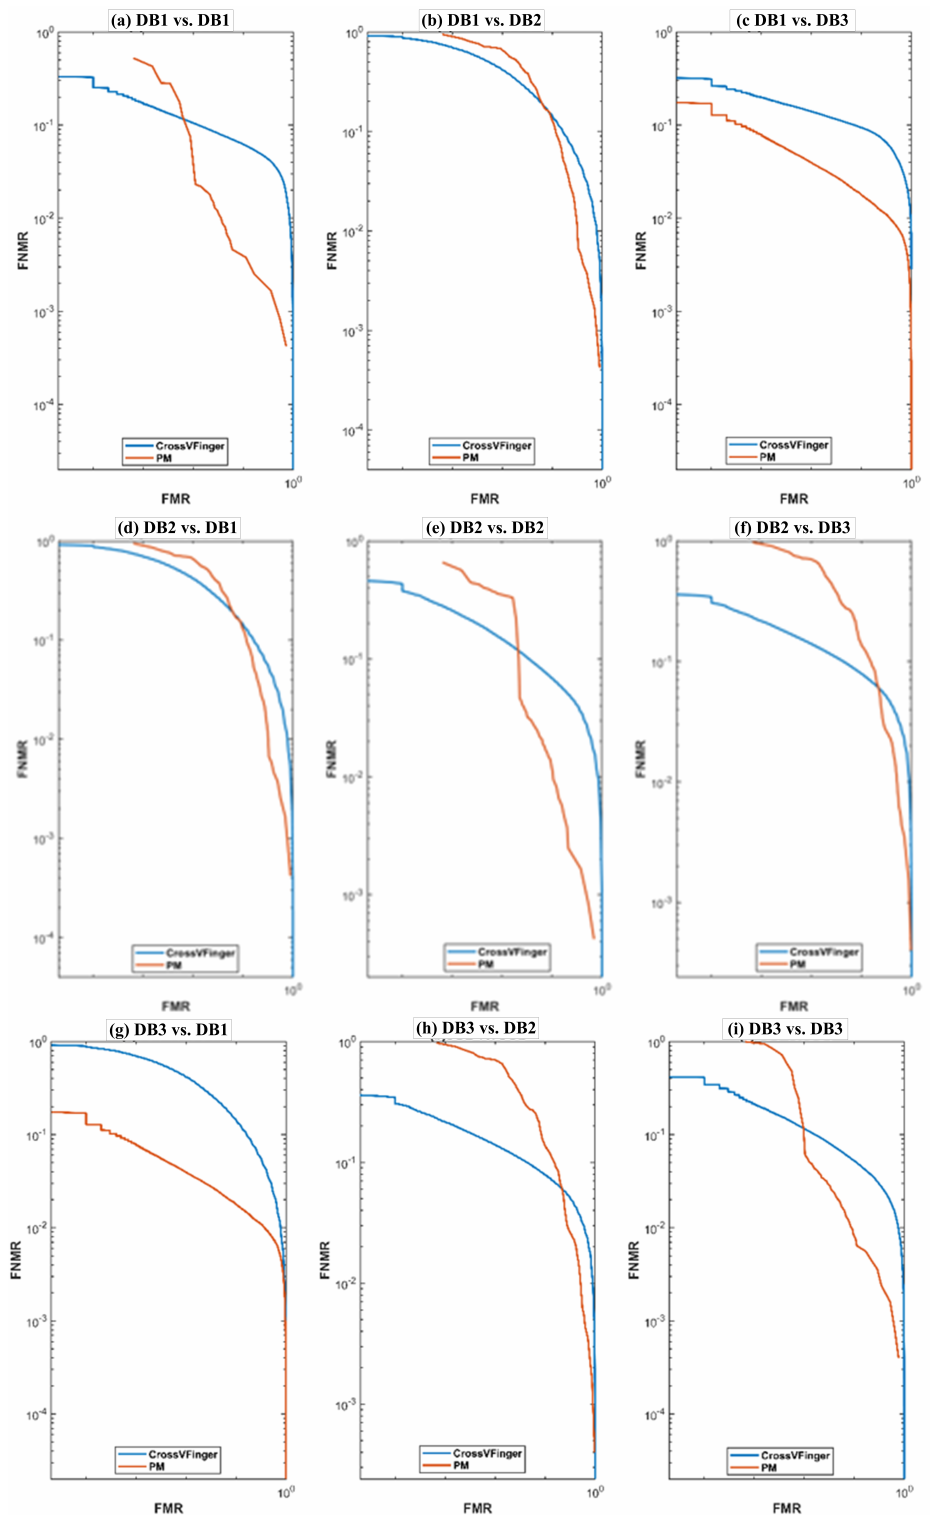
Figure 8. DET curves corresponding to SiameseFinger (PM) and CrossVFinger on the MOLF